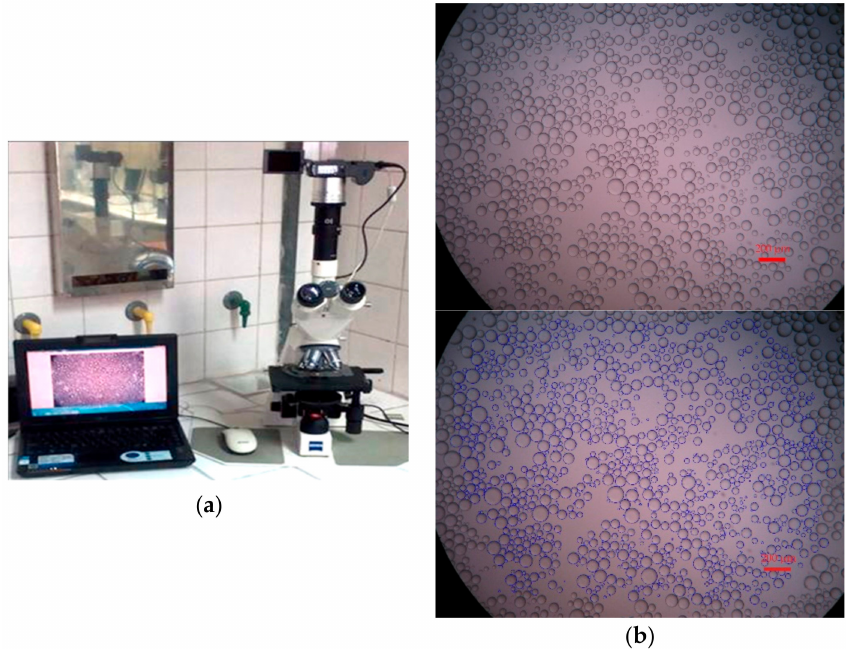
Figure 4. ( a ) Microscope furnished with a digital camera operated through a laptop, (Axiostar Plus, Carl Zeiss Inc.). ( b ) Analysis of microscope images with a custom made software (BubblesEdit